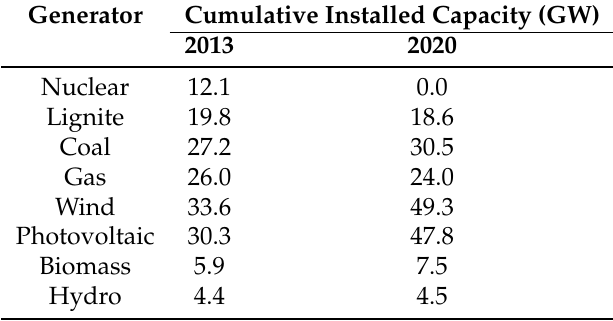
Table 1. Installed power generation capacity modeled for simulations of Germany in 2013 and